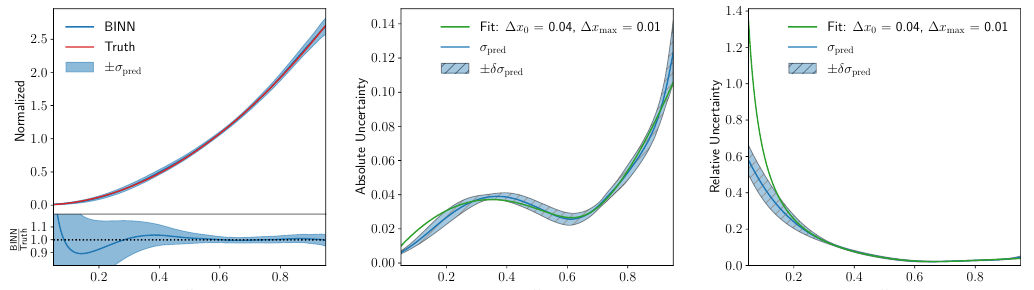
Figure 4: Density and predictive uncertainty distribution for the kicker ramp. In the left panel the density and uncertainty are averaged over several lines with constant y . In the central and right panels, the uncertainty band on σ variation. The green curve represents a two-parameter fit to Eq.(27).